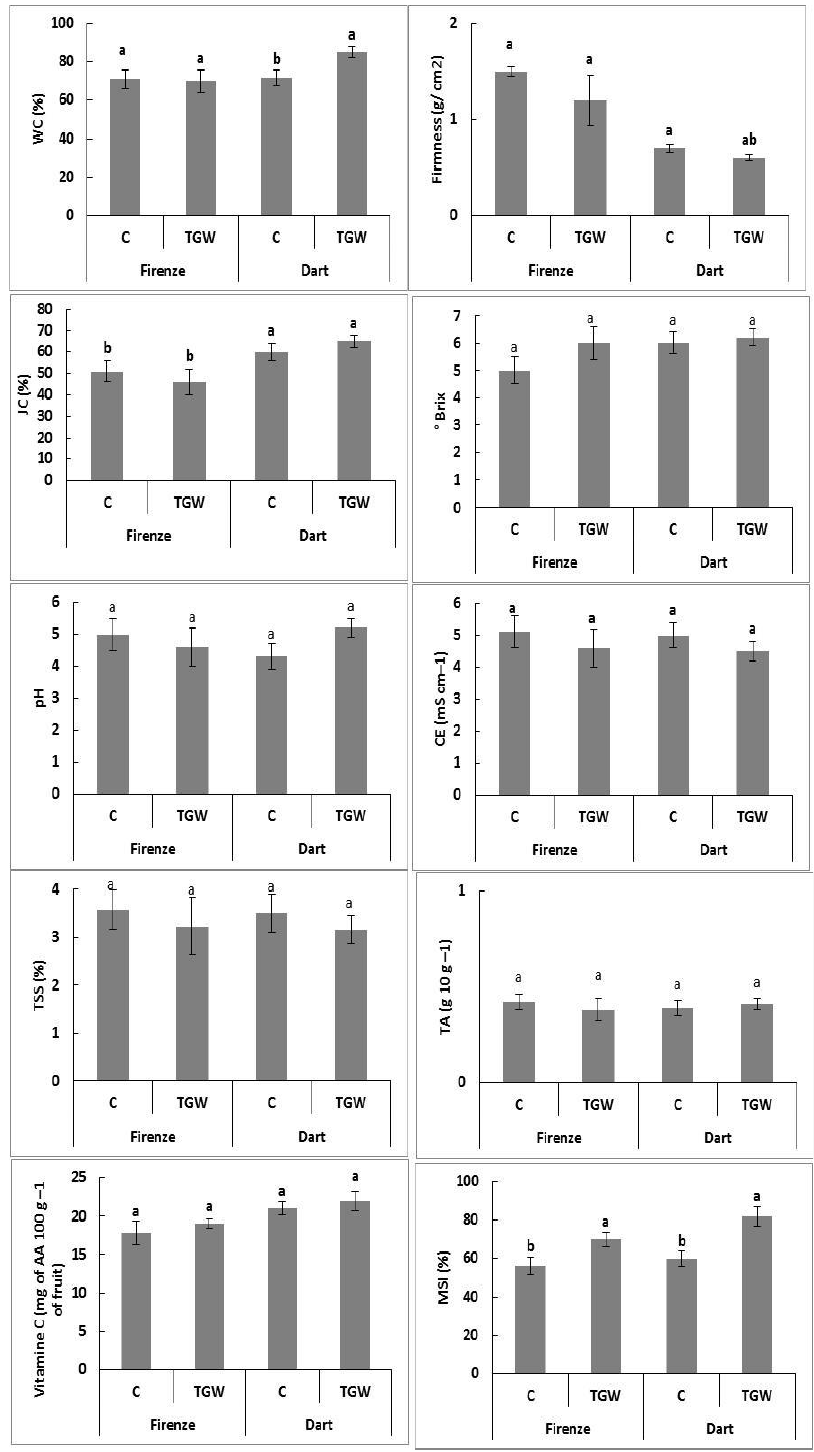
Figure 1. Changes in fruit water content (WC), fruit firmness, fruit juice content (JC), ºBrix (%), pH, electrical conductivity (EC), total soluble salts (TSS), titratable acidity (TA), vitamin C, membrane stability index (MSI) of two tomato cultivars (Firenze and Dart) under two irrigation treatments (C: ground water and TGW: treated grey water). Values are means ± SE of n = 4, different lowercase letters indicate significant difference among treatments and different uppercase letters indicate significant difference between cultivars according to LSD test at p ≤ 0.05.